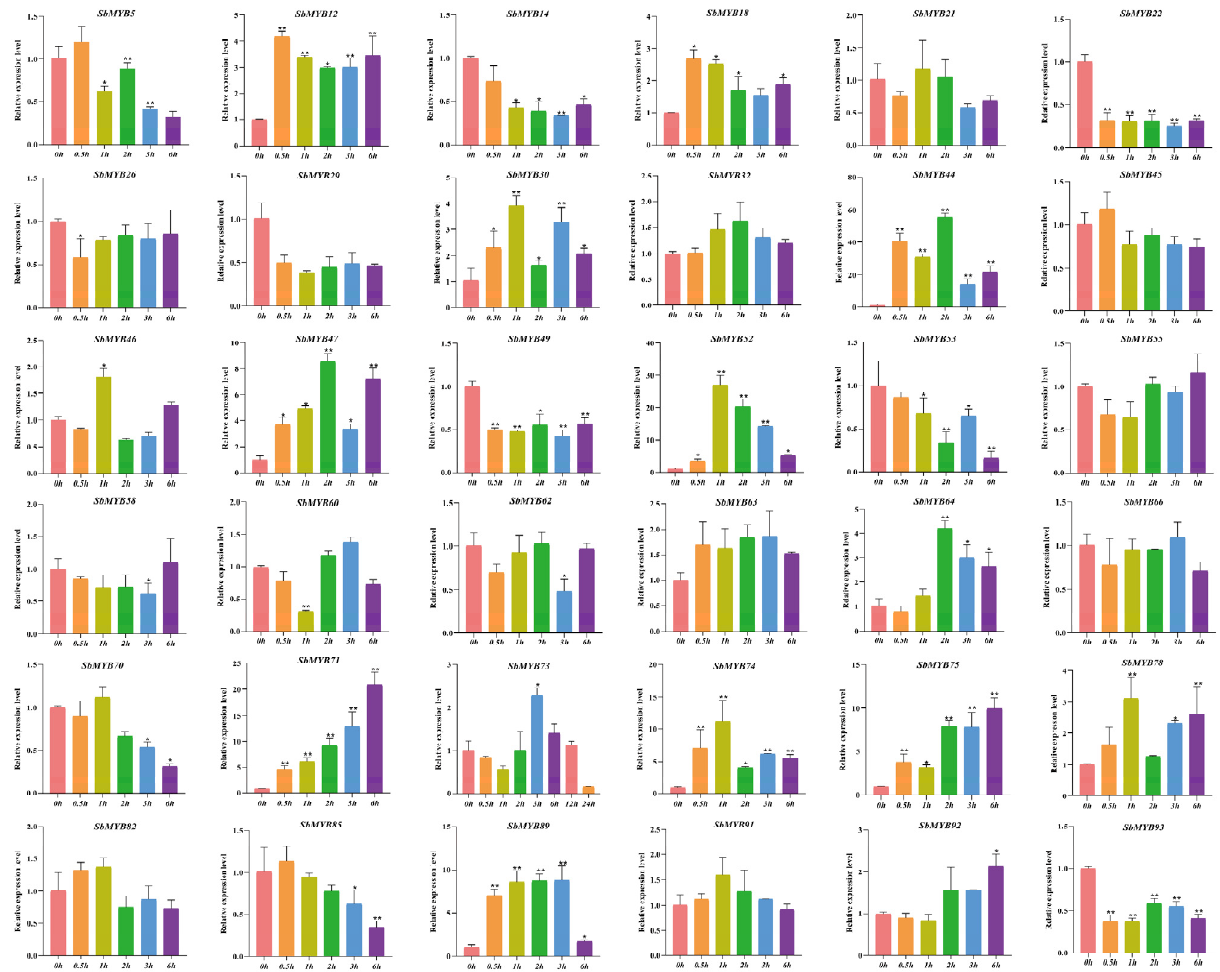
Figure 8. Response to ABA treatments of 36 selected R2R3-SbMYB genes. The reference gene was SbACT7. Comparing the experimental and control groups (0 h), statistically significant differences are indicated by * p < 0.05, ** p < 0.01.